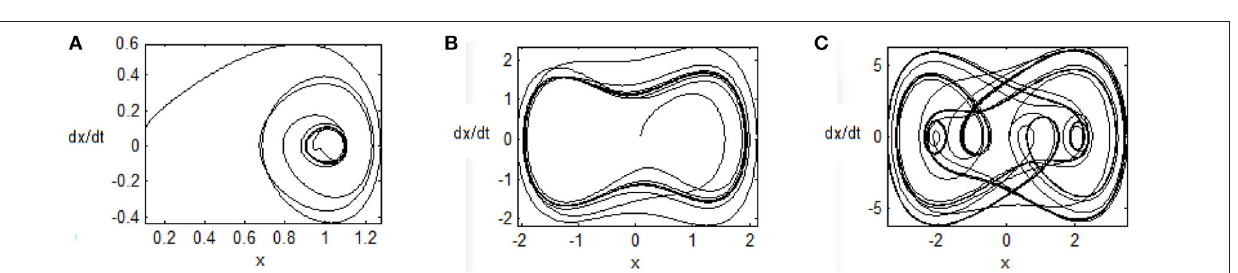
Frontiers in Neuroscience |